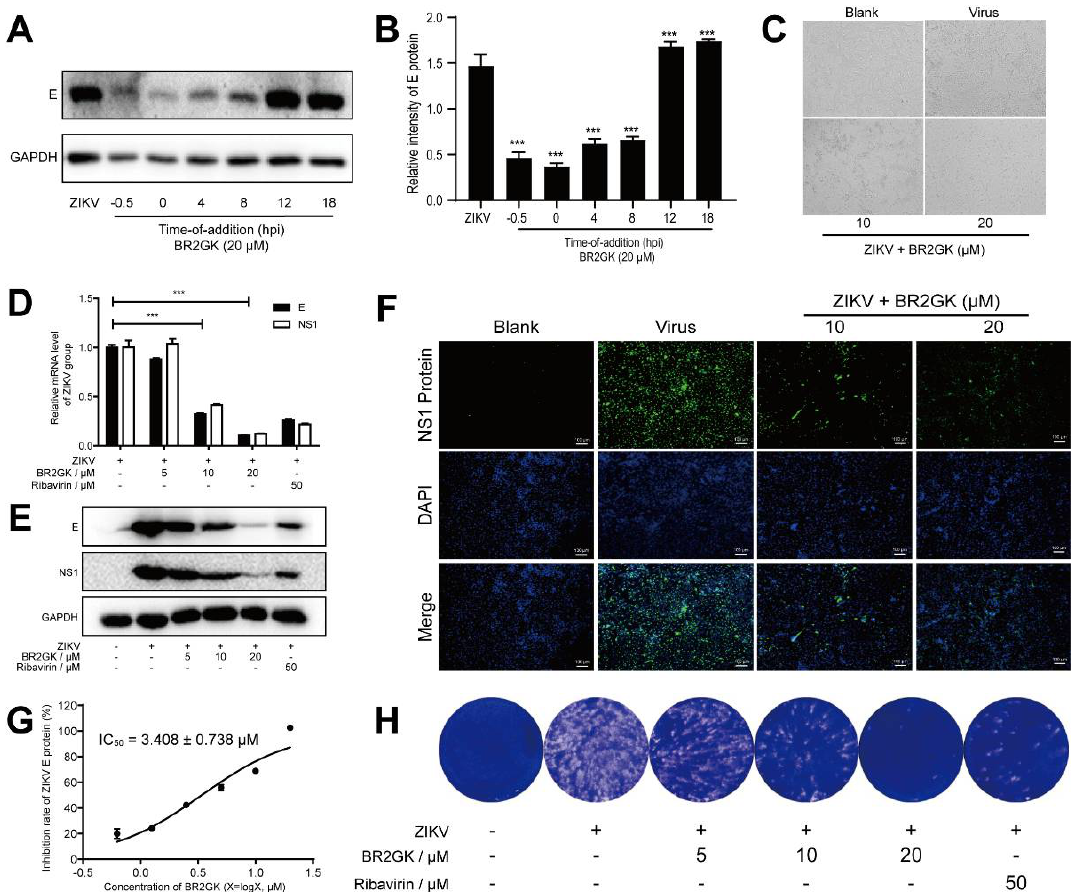
Figure 2. BR2GK inhibited RNA replication and protein synthesis of ZIKV. ( A ) Vero cells were infected with ZIKV for 1 h and treated with 20 μM BR2GK at different time points. The ZIKV E protein was detected by Western blot. ( B ) Western blot densitometric analysis. ( C ) BR2GK reduced virus-induced CPE in Vero cells. Vero cells were infected with ZIKV and treated with BR2GK. After incubation for 72 h, the mRNA and protein expression of E and NS1 were detected by qRT-PCR ( D ) and Western blot ( E ), respectively, with ribavirin as a positive control. ( F ) Expression of NS1 protein was observed by immunofluorescence microscopy. ( G ) Vero cells were infected with ZIKV for 1 h and treated with BR2GK at different concentrations. After incubation for 72 h, the inhibition rate of E protein was detected by cell-based ZIKV immunodetection assay. ( H ) BR2GK reduced the formation of viral plaques. Experimental data are expressed as mean ± SD ( n = 3), *** p < 0.001 compared with the control group.